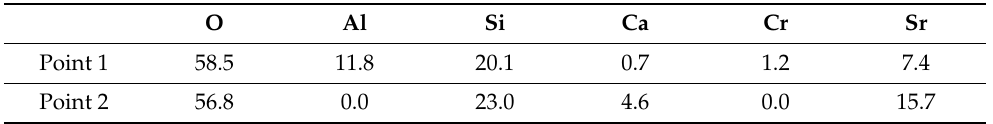
Table 5. EDS point analyses (at.%) performed on the air side of the HJ14 glass-ceramic bonded to the positively polarized Crofer22APU (analysis corresponds to Figure